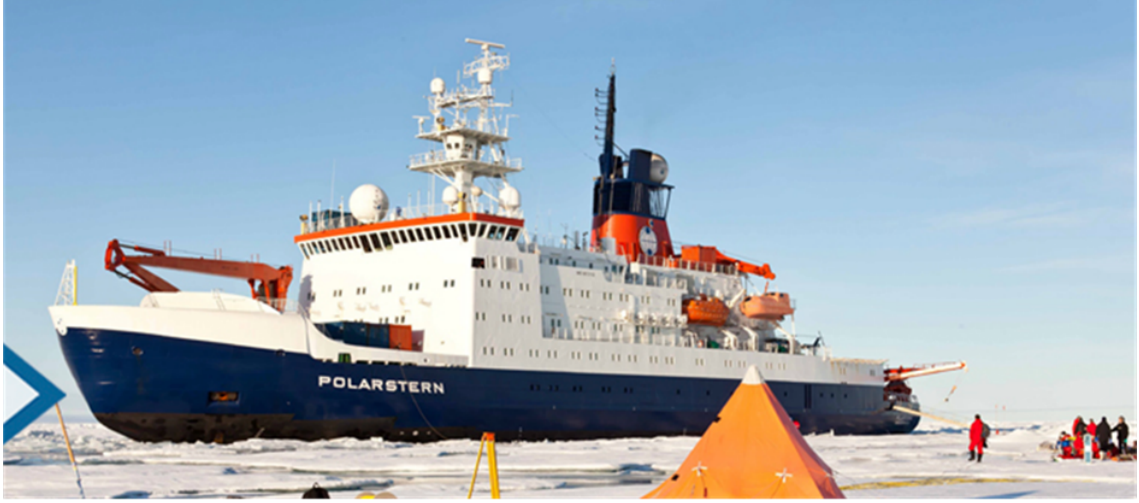
Figure 1: Polarstern working in polar regions. Photo: